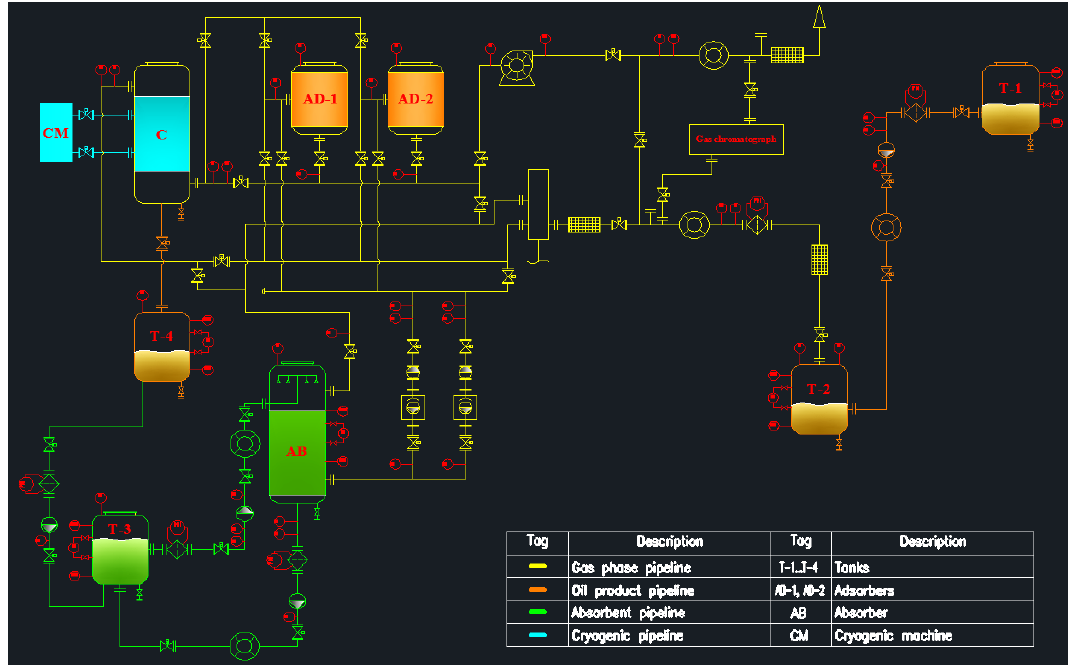
Figure 7. Flow chart of experimental apparatus (designed by Saint-Petersburg mining university).